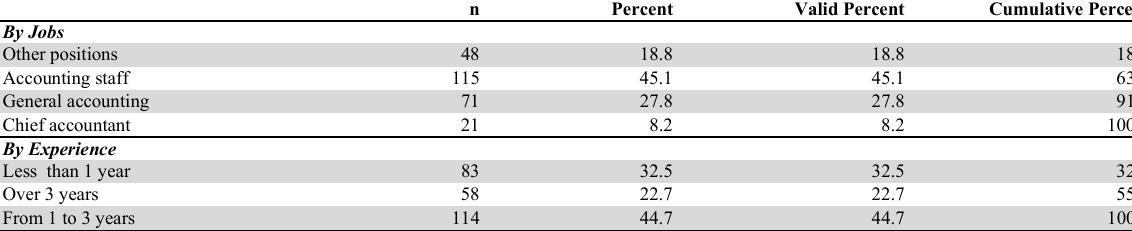
Respondents by Jobs and Work Experience n Percent Valid Percent Cumulative Percent By Jobs Other positions 48 18.8 18.8